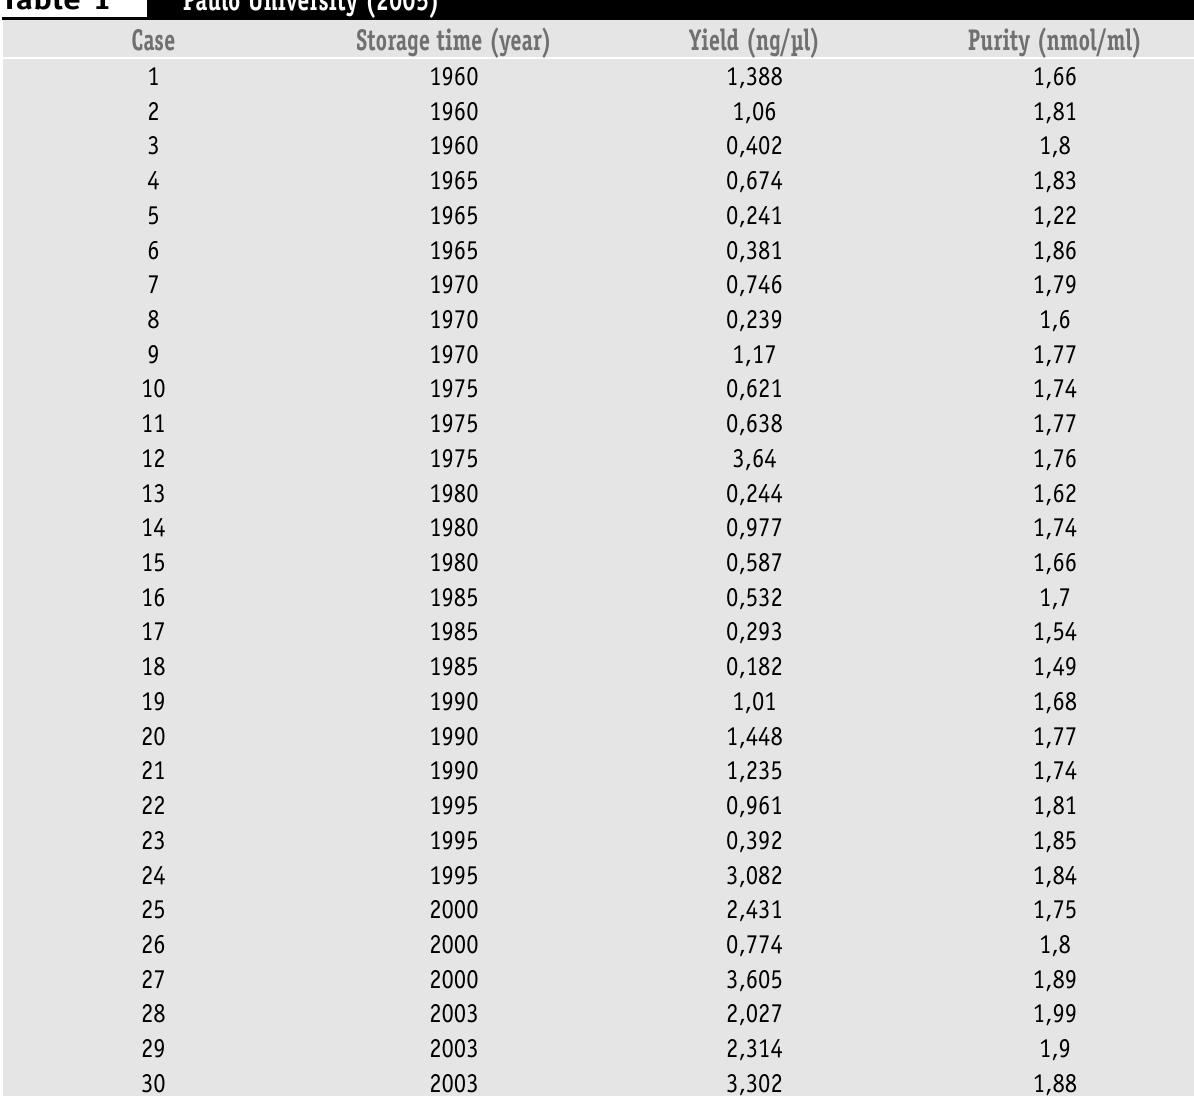
Case, storage time, yield and purity of DNA extracted ( n = 30), Oral Pathology Service of